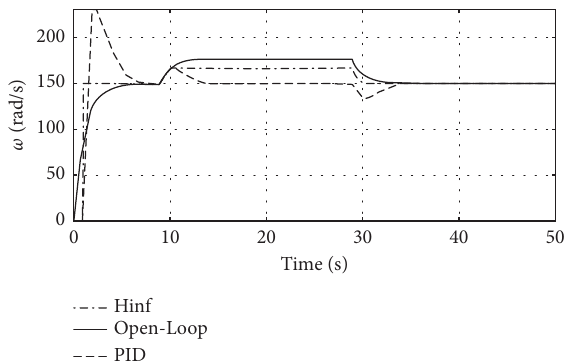
Figure 2: Te angular velocity of the frst order system for τ � 1s for constant disturbance.